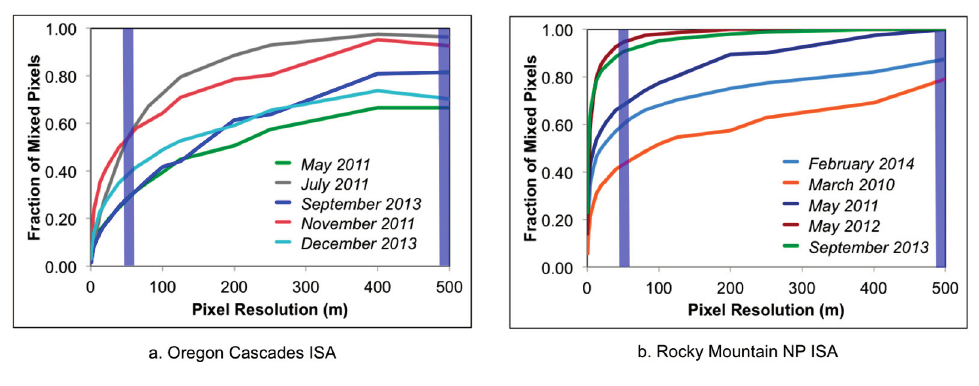
Figure 9. Fraction of mixed (partially snow-covered) pixels for pixel resolutions between 1 m and 500 m, for ( a ) the Oregon Cascades imagery study area, and ( b ) the Rocky Mountain NP imagery study area. Vertical blue lines indicate 40 m spatial resolution (slightly above the nominal spatial resolution for Landsat) and 500 m spatial resolution (the nominal spatial resolution for